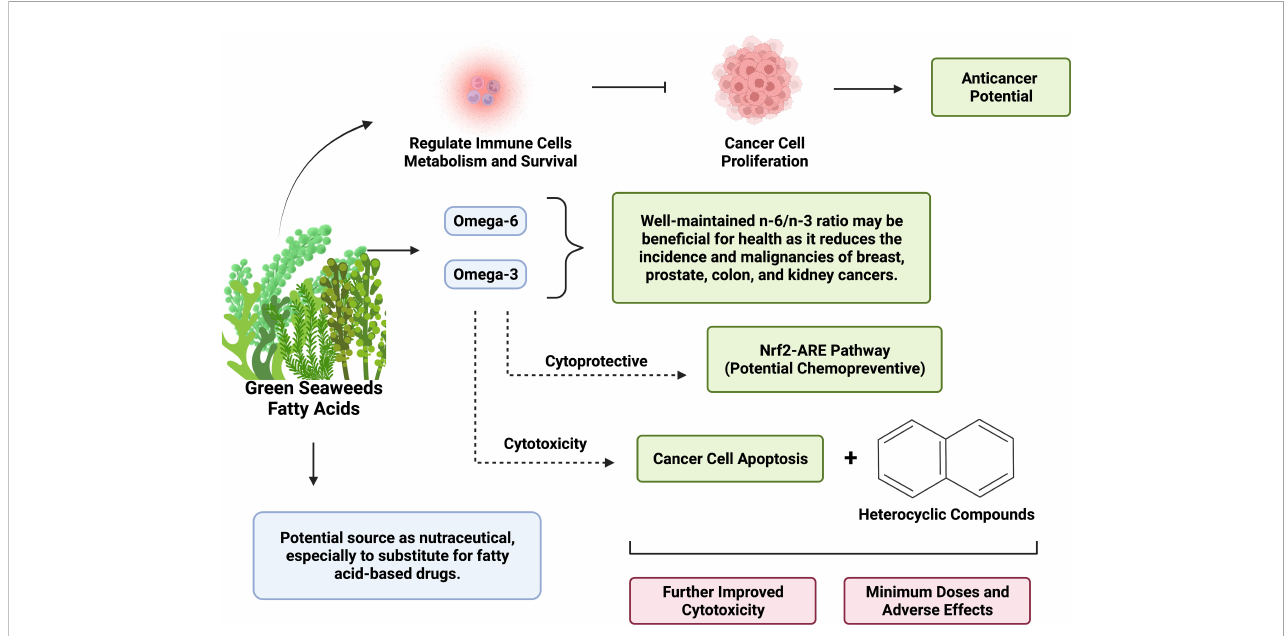
FIGURE 1 Big picture of the anticancer potential of fatty acid-heterocyclic hybrid of green seaweeds as nutraceuticals. Created with BioRender.com premium license by Fahrul